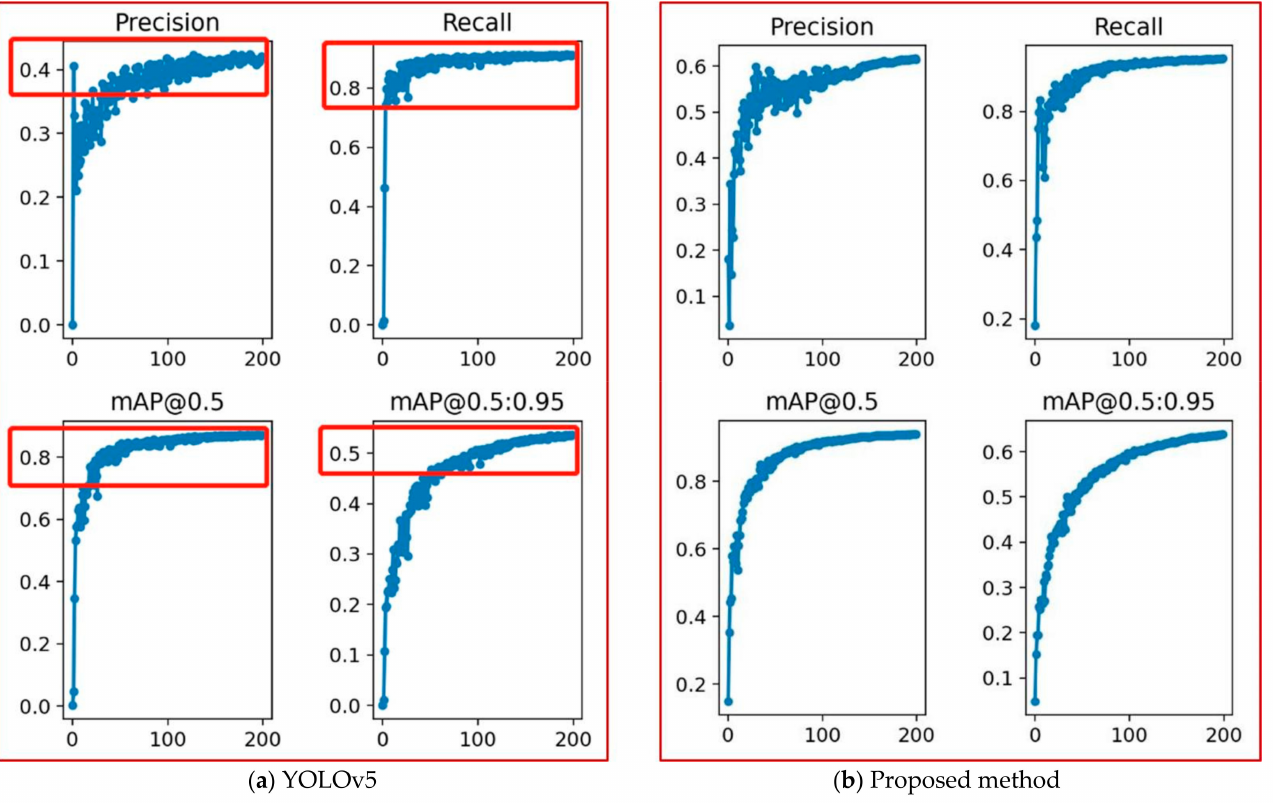
Figure 7. Changes in recall, precision and mAP of the YOLOv5 and the proposed